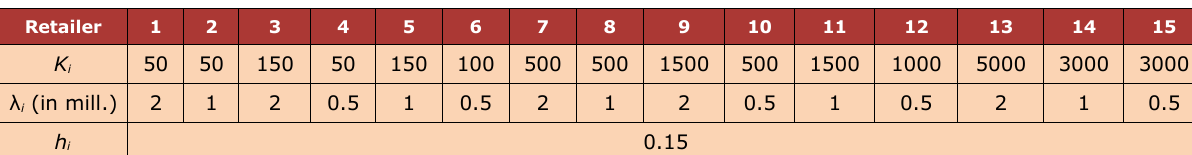
Table 1. Data for